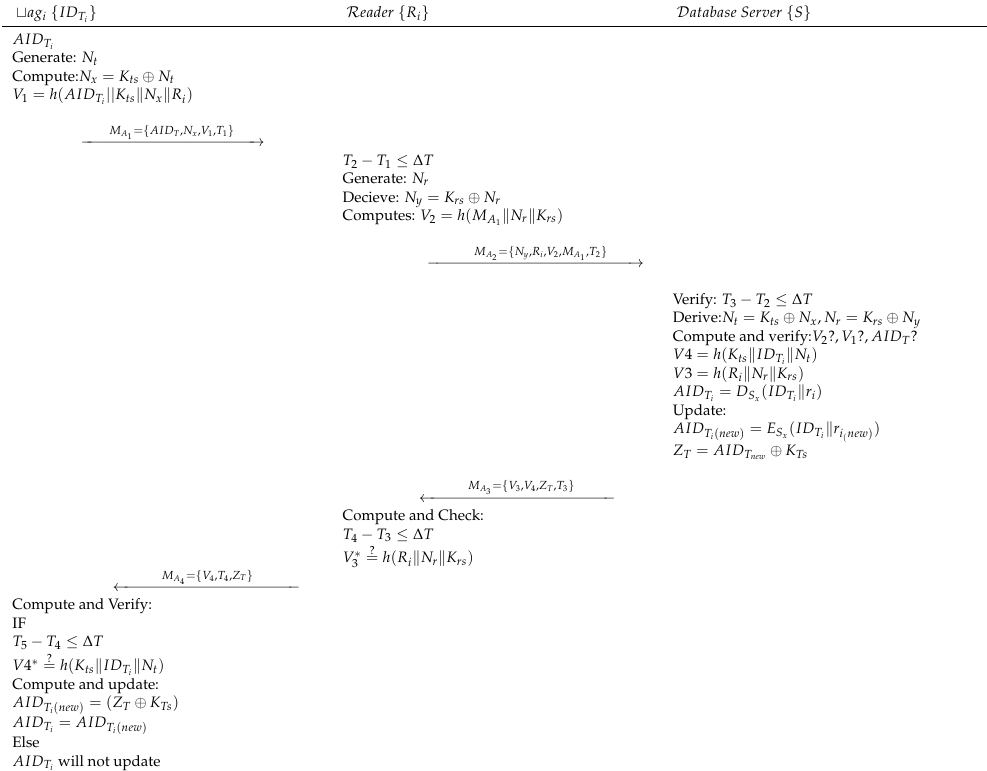
Figure 5. Proposed authentication